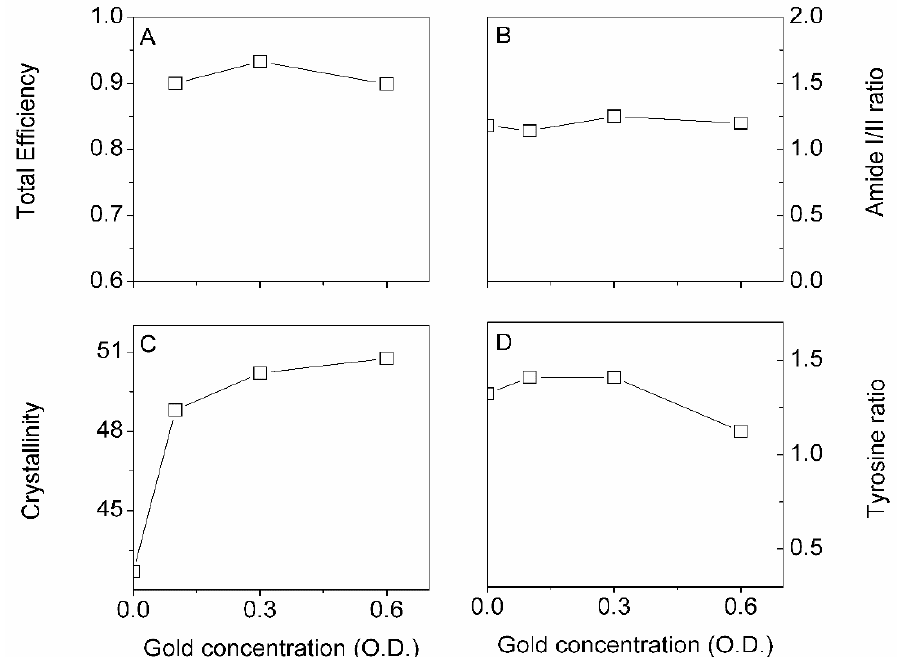
Figure 7. Effect of increasing gold concentration (in optical density O.D.) on total efficiency ( A ), Amide I/II ratio ( B ), Crystallinity ( C ), and Tyrosine ratio ( D ). Interestingly, even though we observed no changes in the amide I/II ratio, we found that the crystallinity and tyrosine ratio were affected. The O.D. concentrations correspond to approximately 6.9, 20.7 and 41.3 µg/mL for the 0.1, 0.3 and 0.6 O.D.